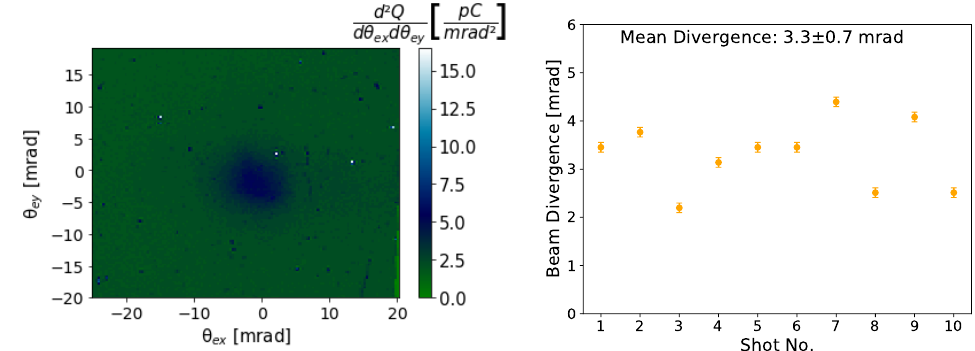
Figure 6. ( Left ): Example of electron beam profile on the diagnostic scintillator, plotted in divergence units ( Right ): shot-to-shot fluctuation of the beam radial divergence; the uncertainty is determined by standard deviation of the